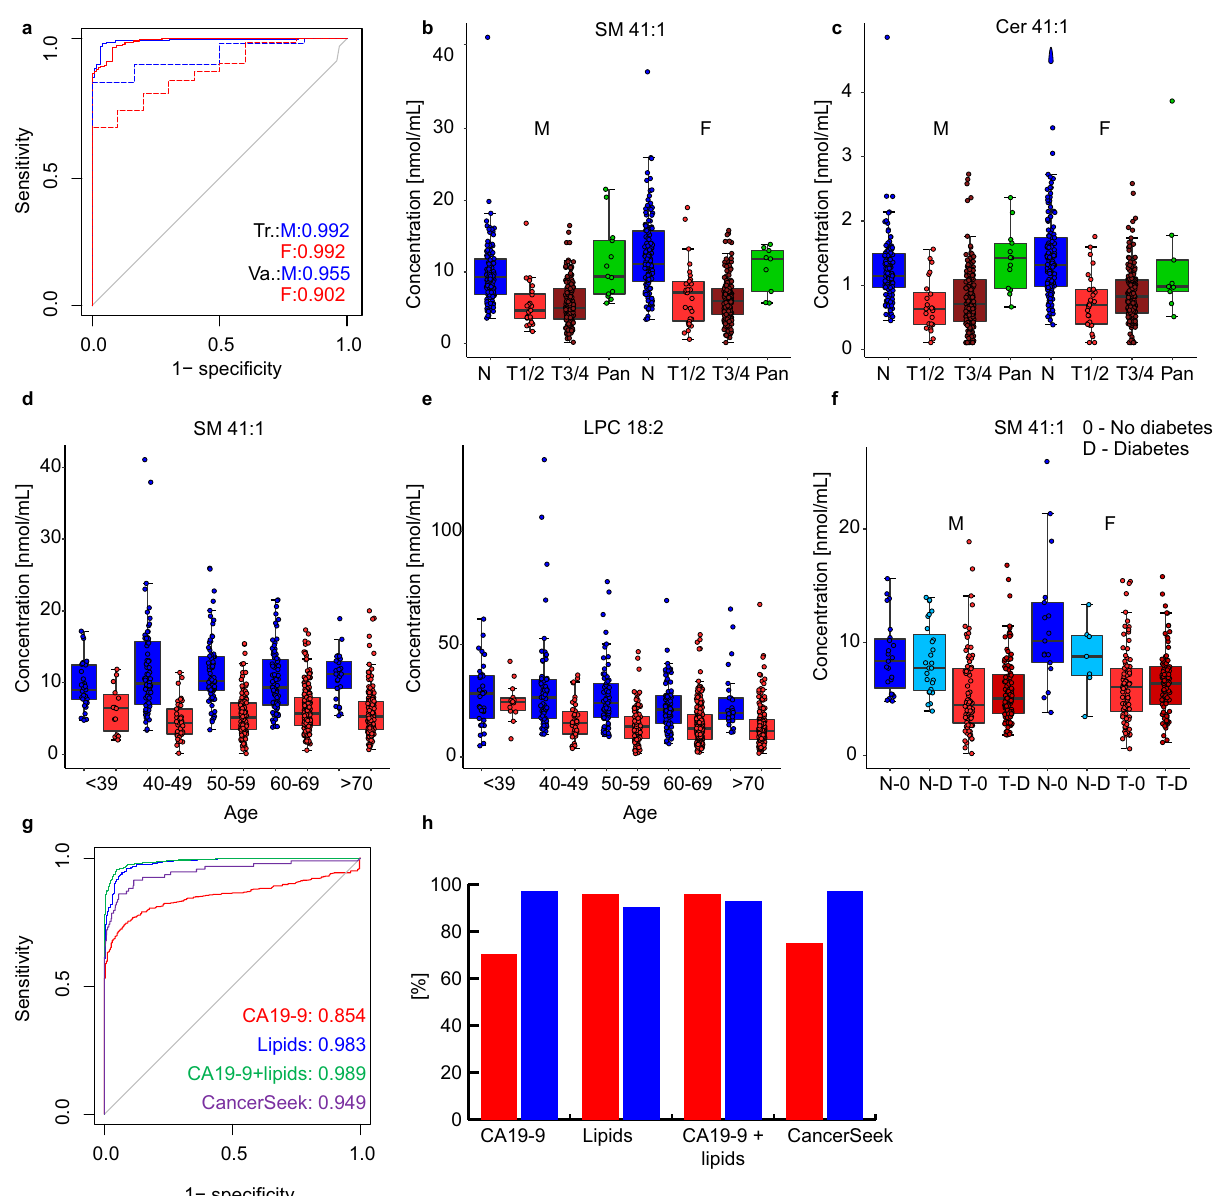
Fig. 7 Results for the lipidomic pro fi ling in Phase III and investigating the in fl uence of cancer stage, age, and diabetes mellitus. a ROC curves for males (M) and females (F) in training (Tr.) and validation (Va.) sets. Box plots of lipid molar concentrations normalized to the NIST reference material for: b SM 41:1 and c Cer 41:1. Only samples with known tumor (T) stage classi fi cation were included, where early stage (T1 and T2, 24 males and 30 females) and late stages (T3 and T4, 174 males and 176 females) are summarized and compared to samples of healthy controls (128 males and 134 females) and pancreatitis patients (13 males and 9 females). Comparison of age intervals for control (blue) and cancer (red) samples ( d ) SM 41:1 and e LPC 18:2. Box plot investigating the in fl uence of diabetes ( f ) SM 41:1. In each box plot, the centerline represents the median, the bounds represent the 1st and 3rd quartile and whiskers span 1.5 fold inter-quartile range from the median. Comparison of the ROC curves for the samples investigated in Phase III for both genders ( g ) red - CA 19-9, blue - lipidomics, green - combination of CA 19-9 and lipidomics, and purple - CancerSeek 32 . h Sensitivity (red) and speci fi city (blue) for CA 19-9, lipidomics, combination of CA 19-9 and lipidomics, and CancerSeek. Source data are provided as a Source Data fi